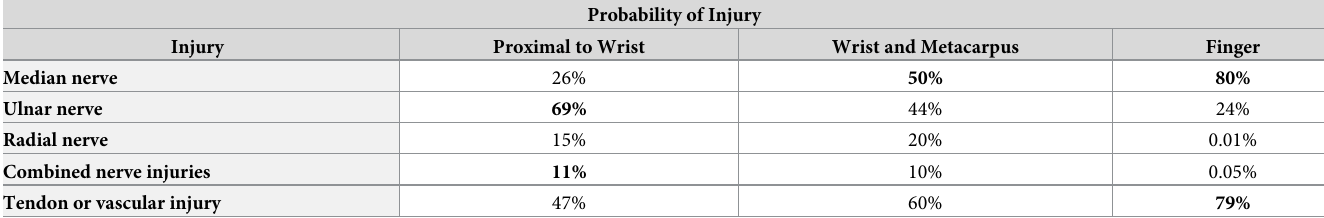
Table 1. Location of injury and relative probabilities to the entire sample. In detail the probability of injury to the three main nerves is described from proximal to dis- tal. Likewise, the probability of combined nerve injury as well as concomitant vascular or tendon injury is